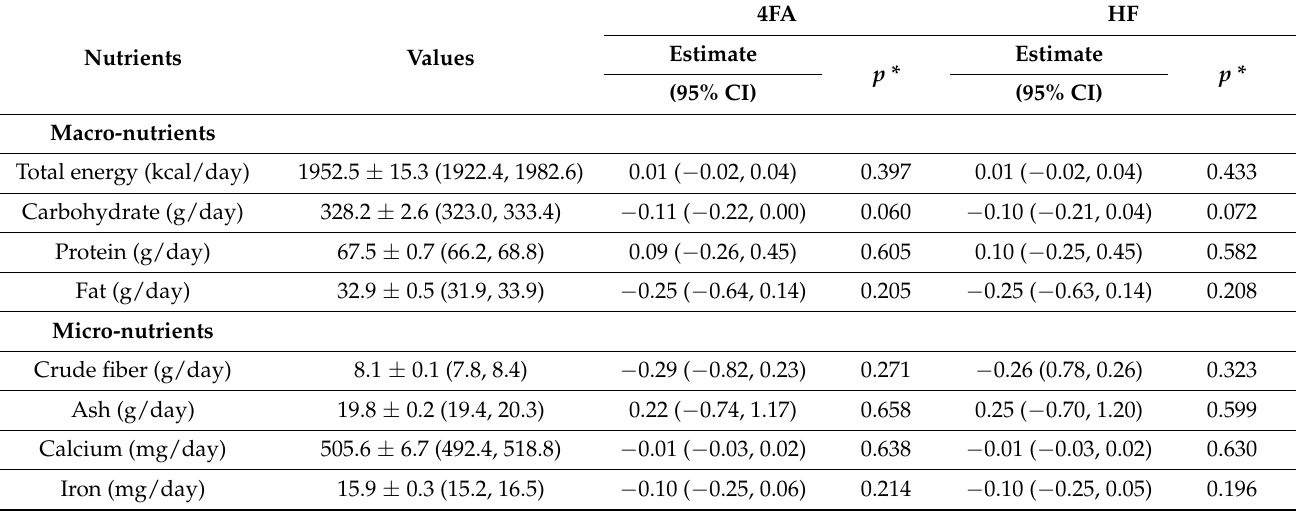
Table 3. Association between nutrient intake and hearing